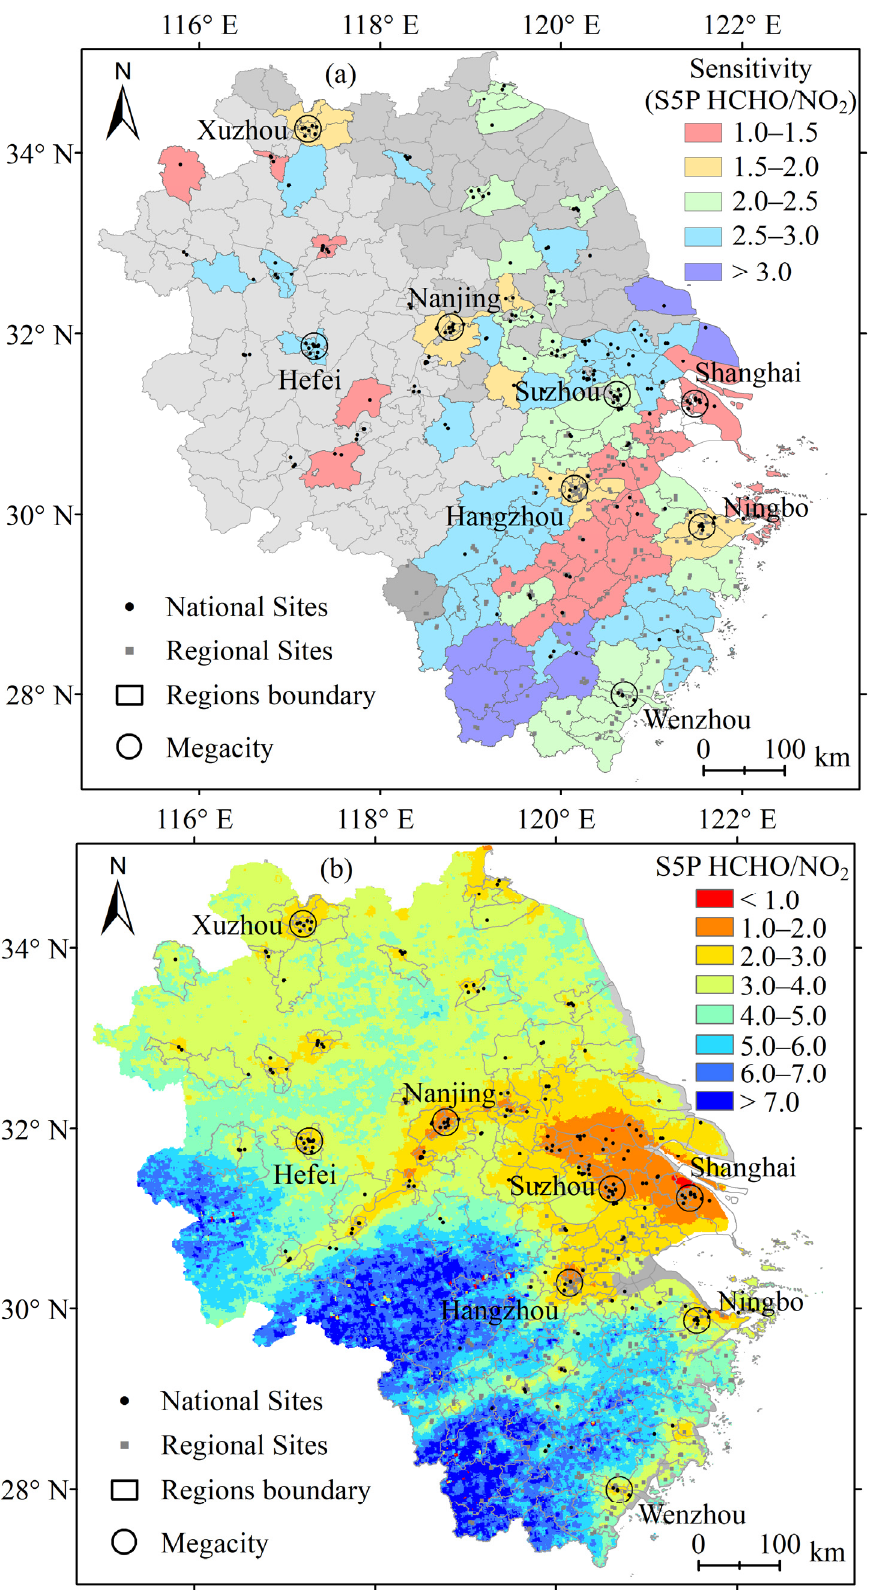
Figure 8. ( a ) Sub-county scale HCHO/NO 2 ratio (HNR) thresholds from dense measurements and ( b ) Sentinel 5P observed mean values of HNR during April–September over